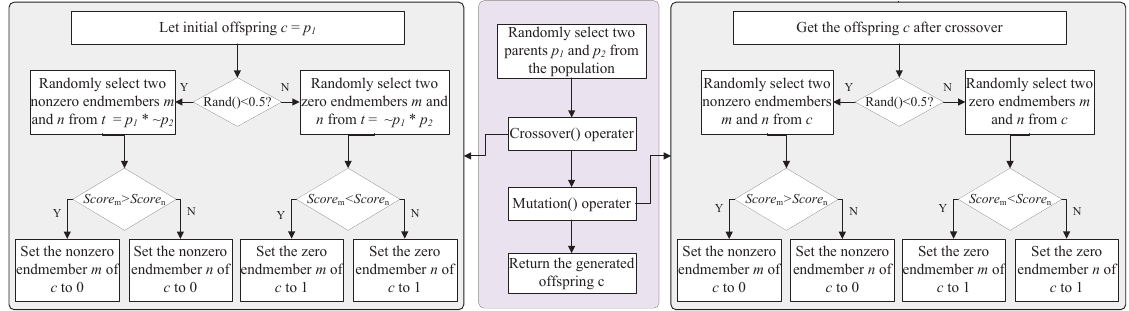
Figure 3. Illustration of the flow of crossover and mutation operators. The middle procedure represents the generation process of a offspring, the left procedure represents the crossover operation, and the right procedure represents the mutation